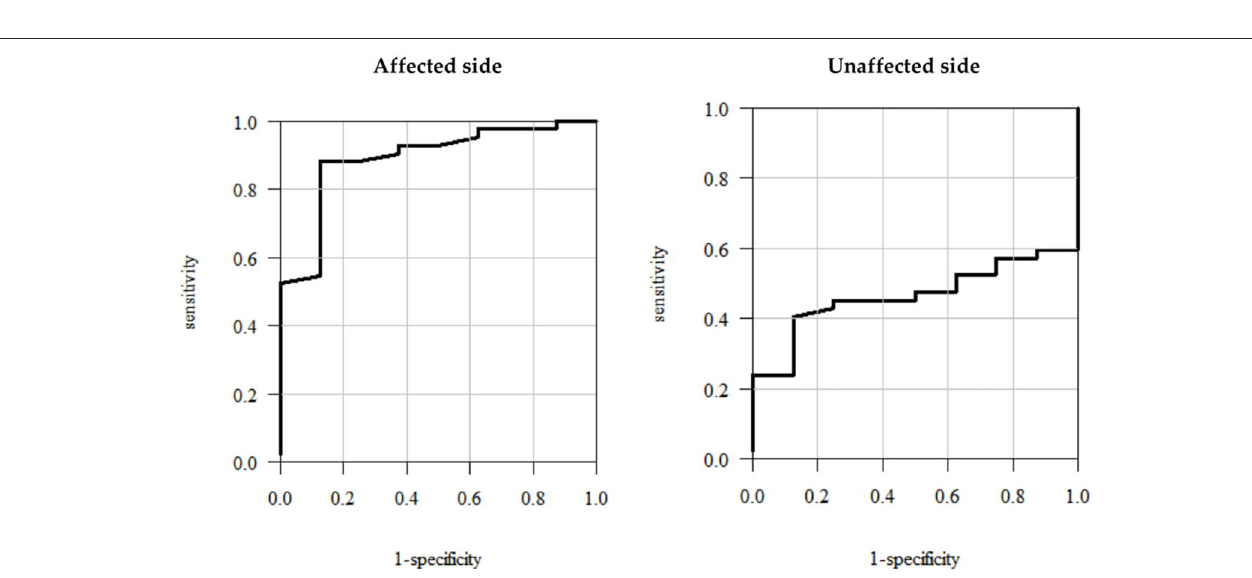
FIGURE 2 | Scatterplots representing linear regression reflecting the correlation between the change in the hip FE ROM (dependent variable), separately for the affected and unaffected sides and the change in the BI (independent variable).